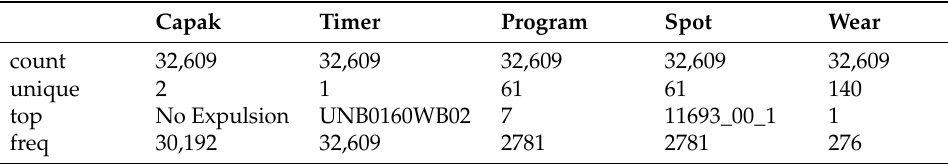
Figure 7. Expulsion and heat relationship. Table 5. Summary of categorical variables in data set.